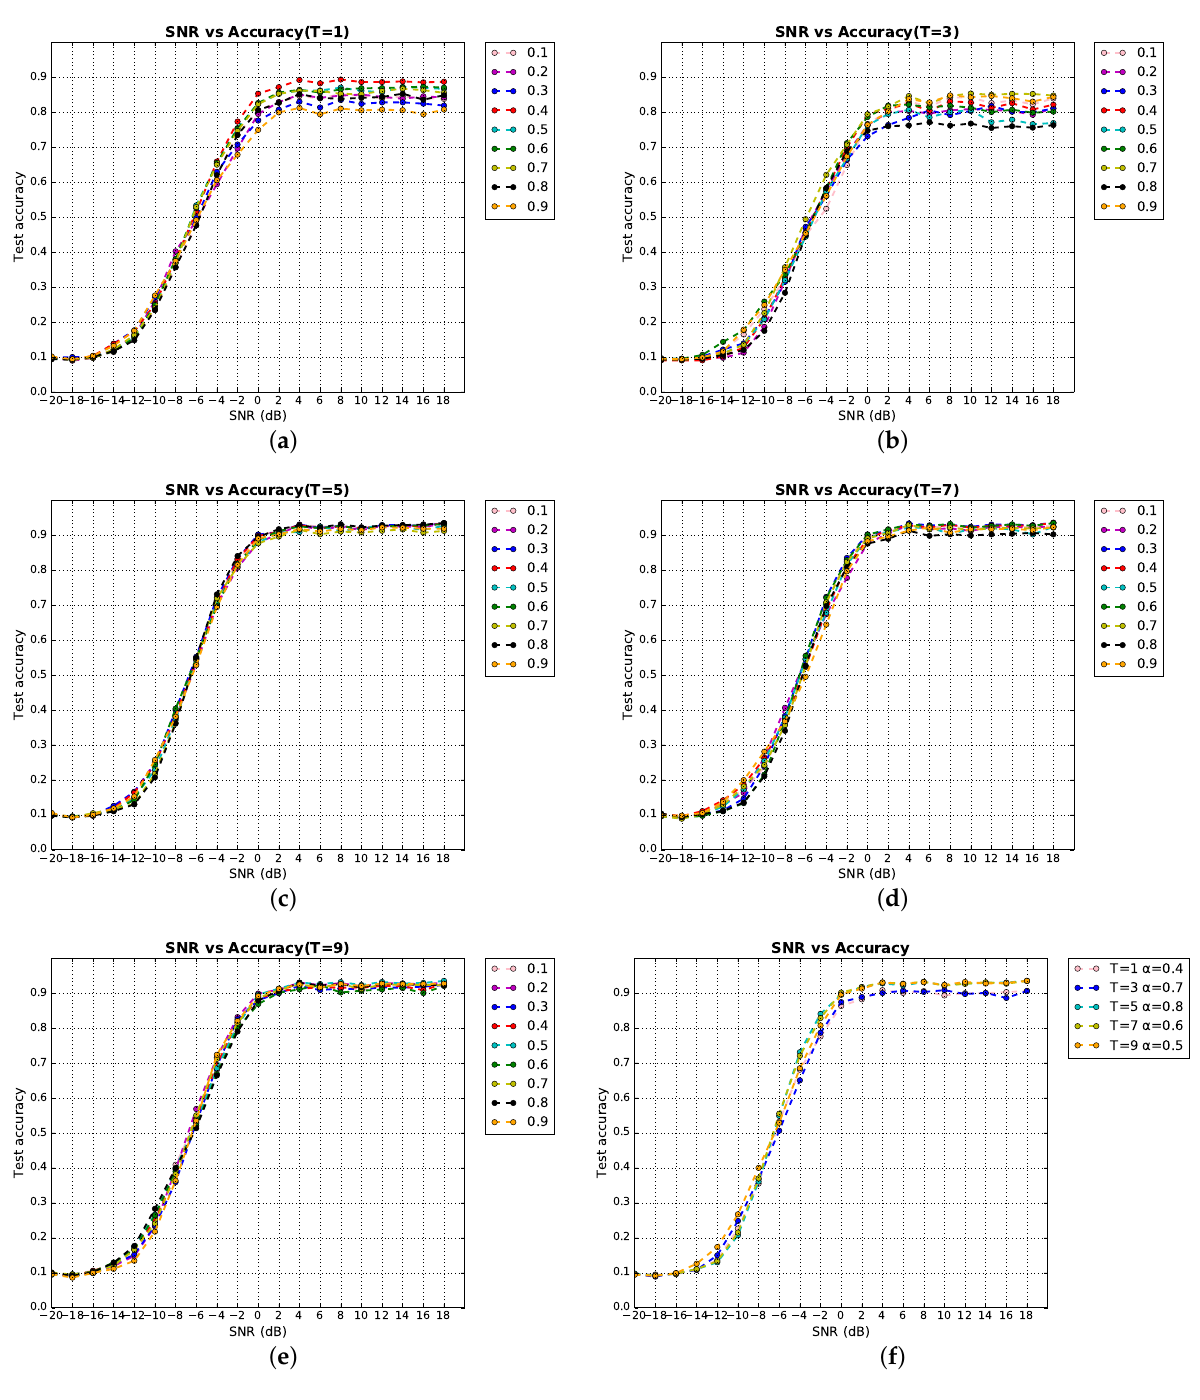
Figure 14. Mini Inception–Resnet classification accuracy after knowledge distillation with different parameters. ( a ) Classification accuracy of student networks corresponding to different α at T = 1; ( b ) at T = 3; ( c ) at T = 5; ( d ) at T = 7; ( e ) at T = 9; ( f ), the best classification accuracy in each T. Figure 15 depicts the optimal DSCNN3 classification accuracy. Once the SNR exceeded 0 dB, the network’s classification accuracy became flat, and the classification accuracy of CNN3 was stable at around 78% and that of DSCNN3 around 89%. According to Table 1, CNN3 had a peak classification accuracy of 0.7981; DSCNN3, 0.8936; Inception–Resnet, 0.9309. Without changing the network’s size or computational effort, knowledge distillation improved CNN3’s peak classification accuracy by